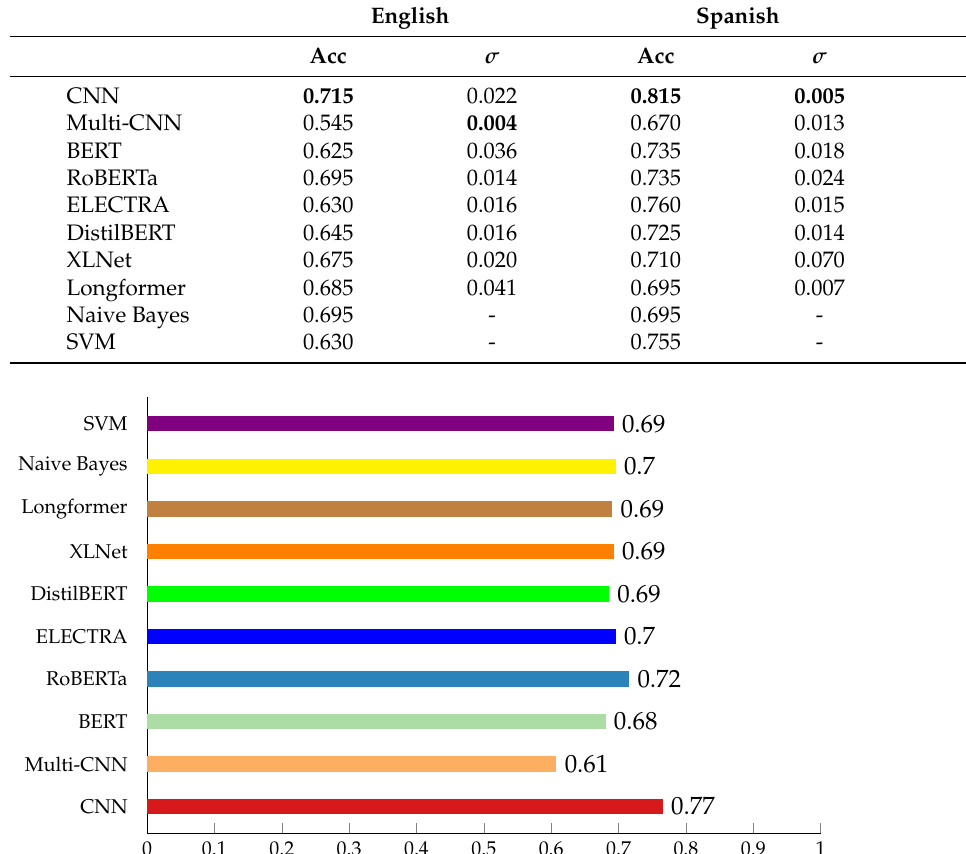
Table 4. Models accuracies and standard deviation. For non-deterministic models accuracy is the median over five runs. In the table, the best results are shown in bold.